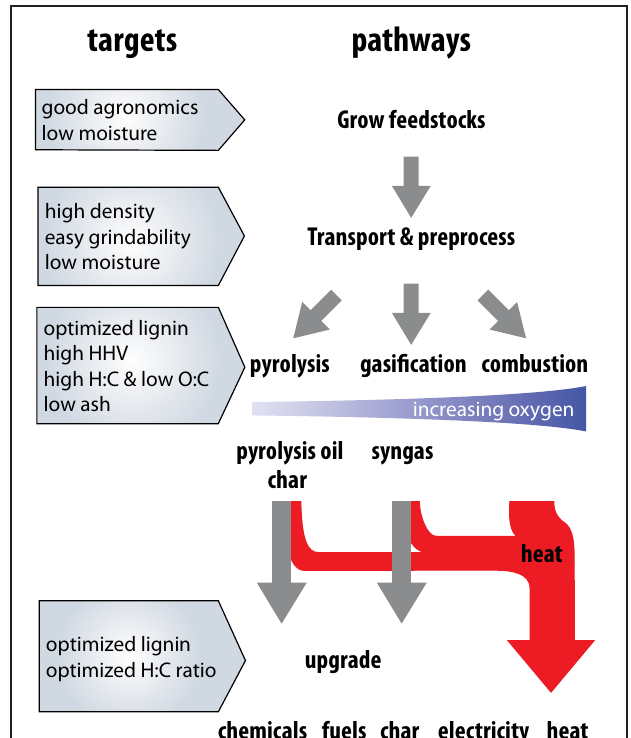
FIGURE 1 | Overview of the steps involved in growing, transporting, processing, and converting biomass into thermochemical energy products. Pyrolysis, gasification, and combustion take place under conditions of increasing oxygen availability during the reactions. Particle residence time and temperature may be optimized to yield different proportions and types of products. Boxes represent the properties important for each step (growing, transport and processing, conversion, upgrading). The primary products of each process and the potential end uses are highlighted. Note that intermediate products such as syngas and pyrolysis oil can be upgraded to chemicals or liquid transportation fuels or converted to obtain electricity and heat. Agronomic traits include those traits that allow the plant to survive and produce acceptable